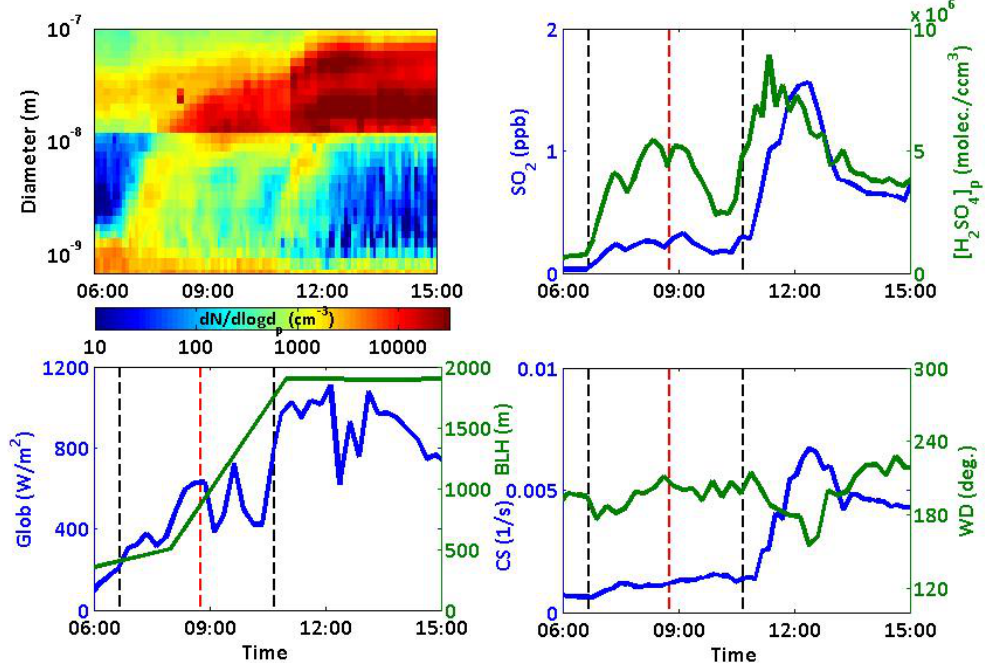
Fig. 6. Example of two consecutive nucleation and growth events (top left panel) at Botsalano on 6 November 2007. The concentration of SO 2 and H 2 SO 4 -proxy (top right panel), values of CS and wind direction (bottom right panel), and boundary layer height and global radiation (bottom left panel) are also presented. The first black and red lines indicate the start and end of the first nucleation event, while the second vertical black line indicates the start of the second event. Nocturnal ∂θ/∂z >